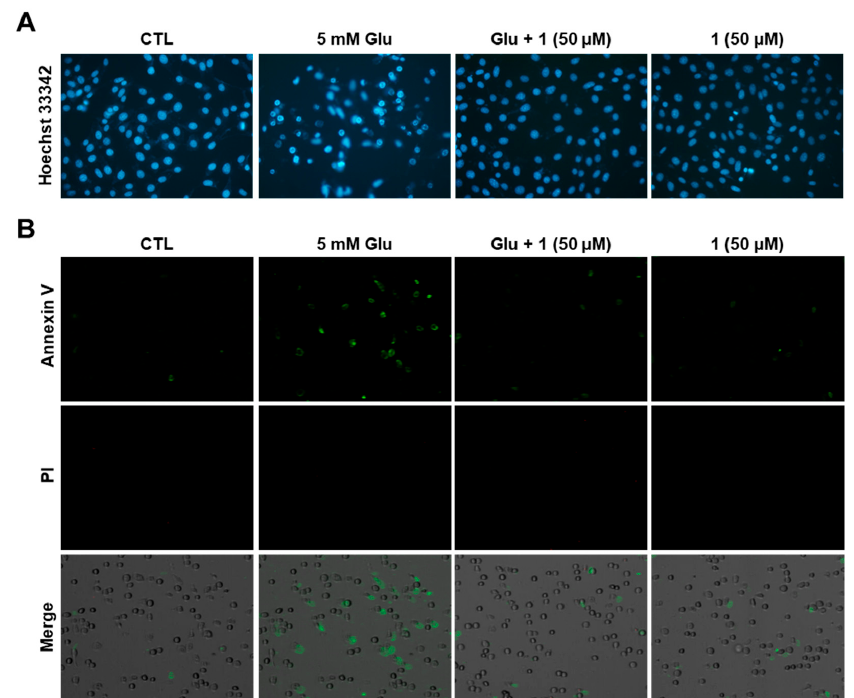
Figure 6. Compound 1 inhibited glutamate-induced apoptotic HT22 cell death. (A) HT22 cells were treated with 5 mM glutamate in the presence of 1 for 12 h and stained with Hoechst33342. Fluorescent images were obtained using a fluorescence microscope (40×). (B) HT22 cells were treated with 5 mM glutamate for 12 h in the presence of 1 and stained with Alexa Fluor 488-conjugated annexin V and propidium iodide. Fluorescent images were obtained using a Tali Image-Based Cytometer.